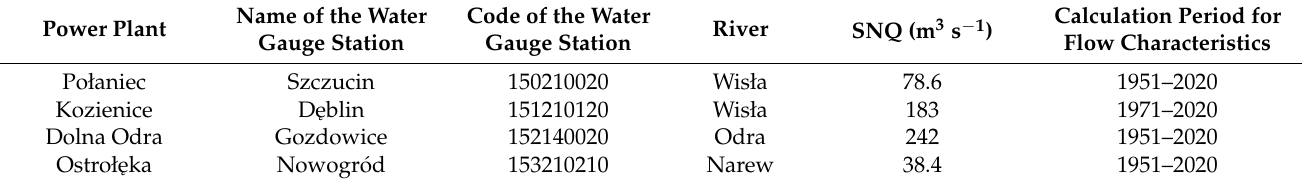
Table 2. Characteristics of the IMGW-PIB water gauge stations located above the power